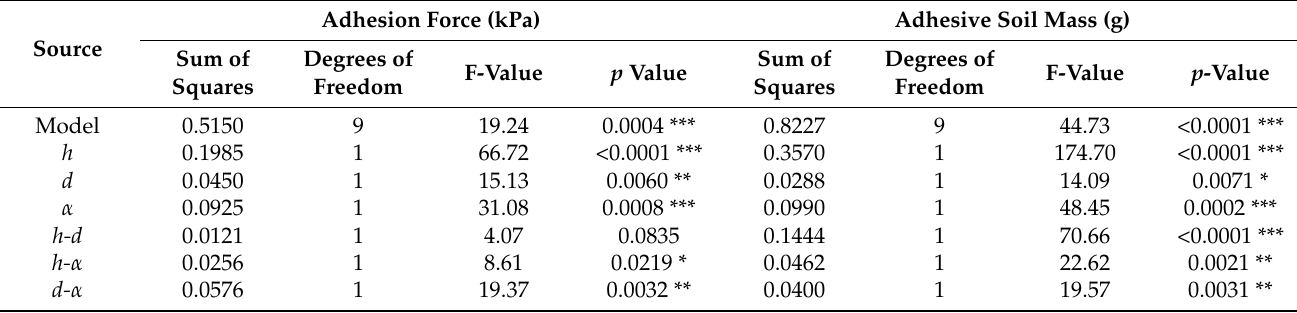
Table 4. Analysis of variance for the response